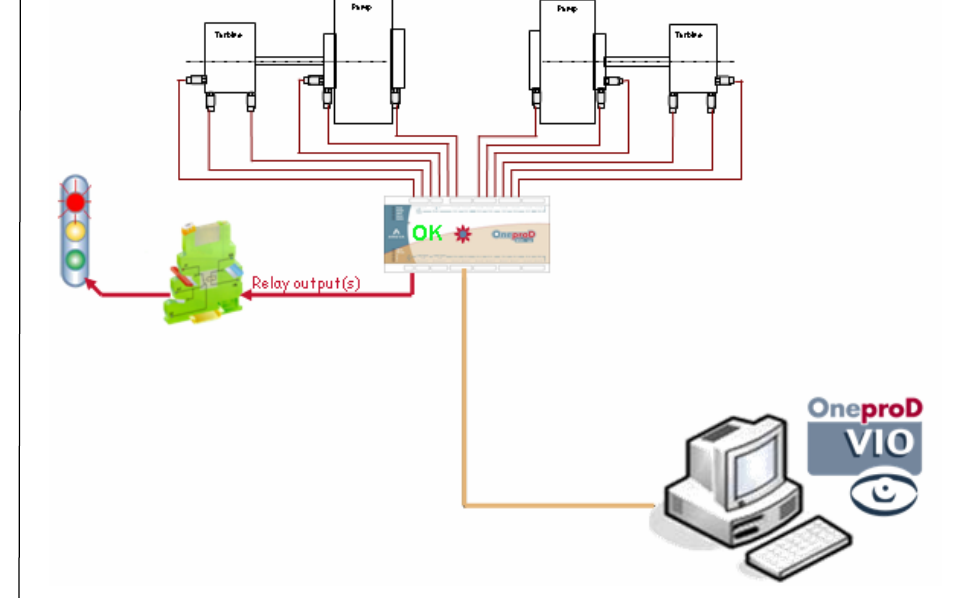
Figure 3 – The monitoring system for the mini hydropower plants in Šavnik Рис . 3 – Система мониторинга на мини - ГЭС в